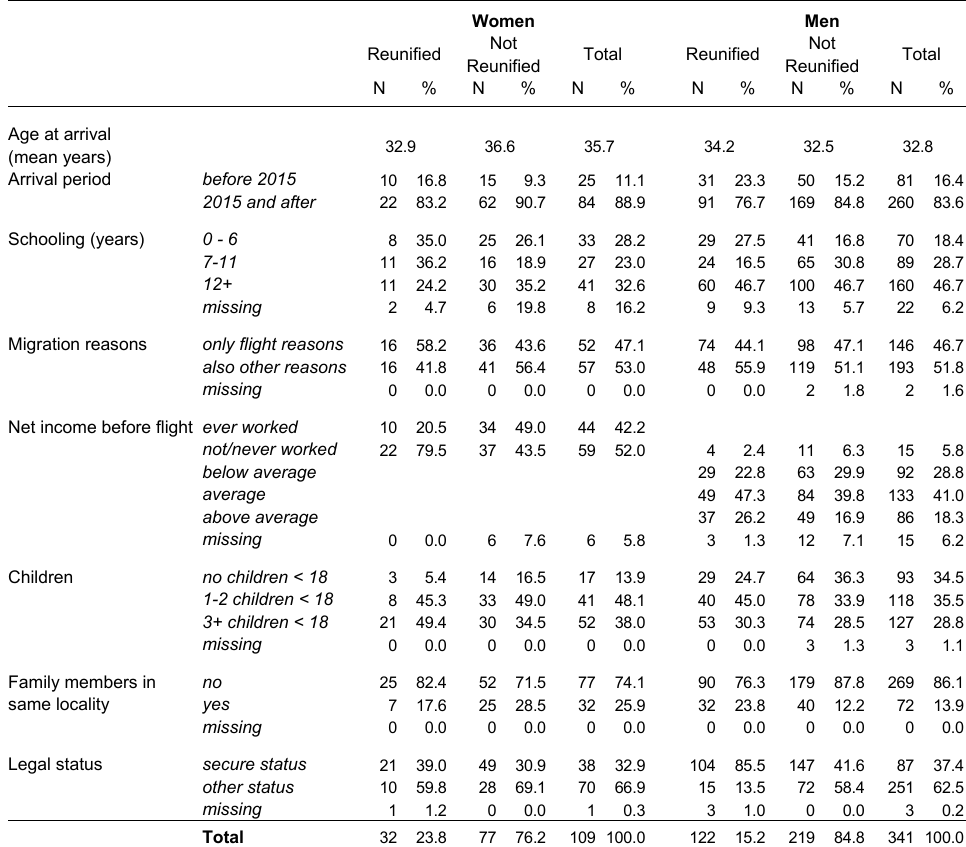
Table A1 : Descriptive statistics of independent variables by sex; reunified versus not re- unified within one year of arrival of first-mover (step